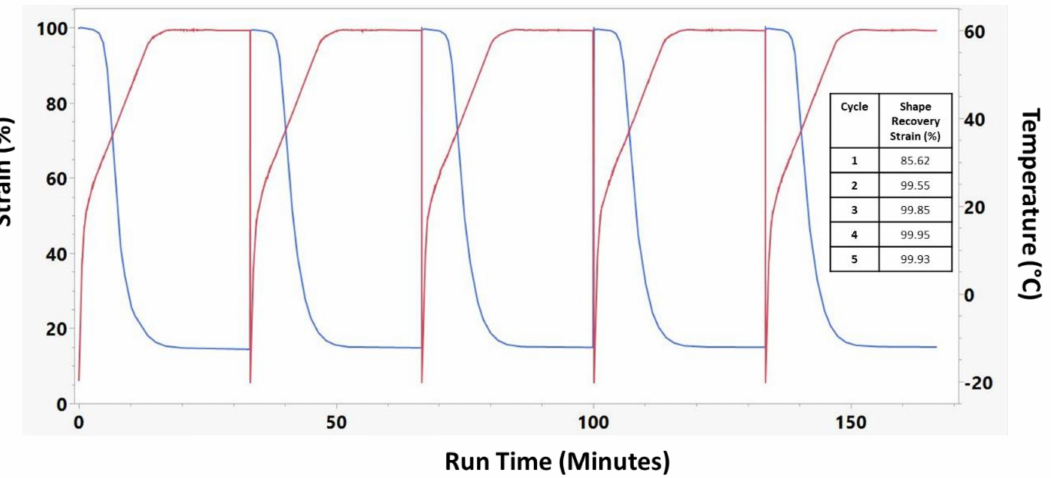
Figure 8. Cyclical shape recovery of 30% Acet, 30 min crosslinked electrospun sample. 5 full shape recovery cycles were performed. Red lines indicate the temperature while blue lines indicate the sample